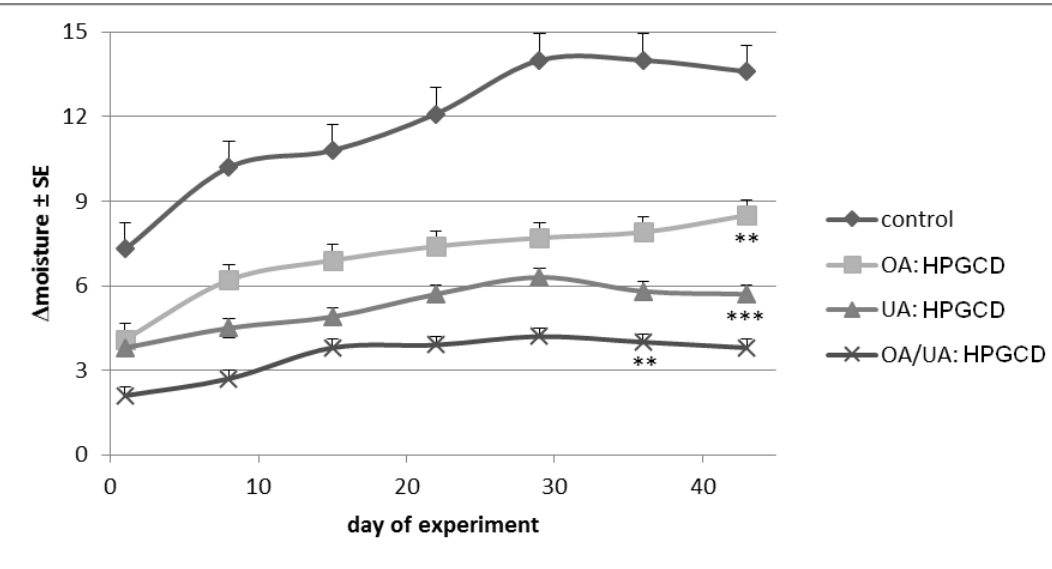
Figure 12. Stratum corneum moisture